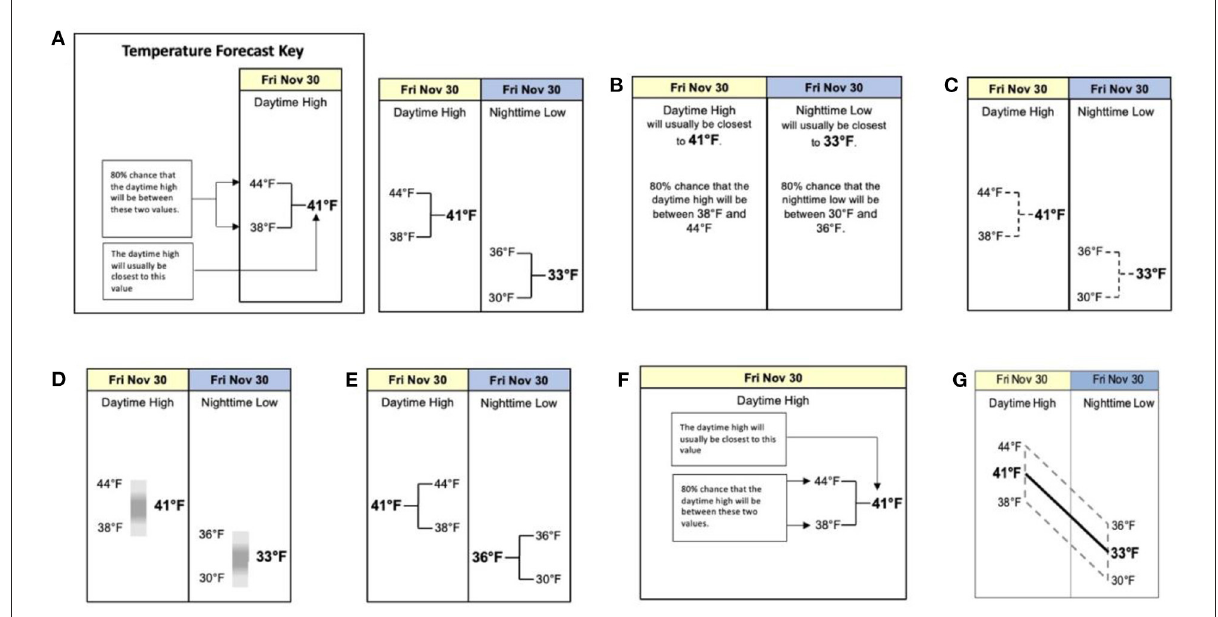
FIGURE1 Predictive intervals, each accompanied by a key (shown in a) describing “41 ◦ F” as the “best forecast.” Font and figure sizes are slightly smaller than they were in the original experiments to conform to journal requirements.